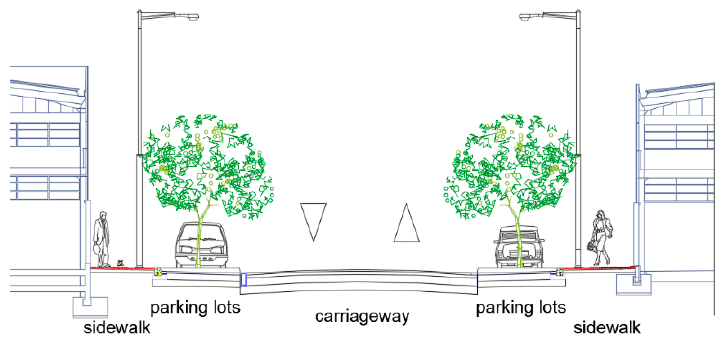
Figure 3. Cross-section of the examined urban roads.